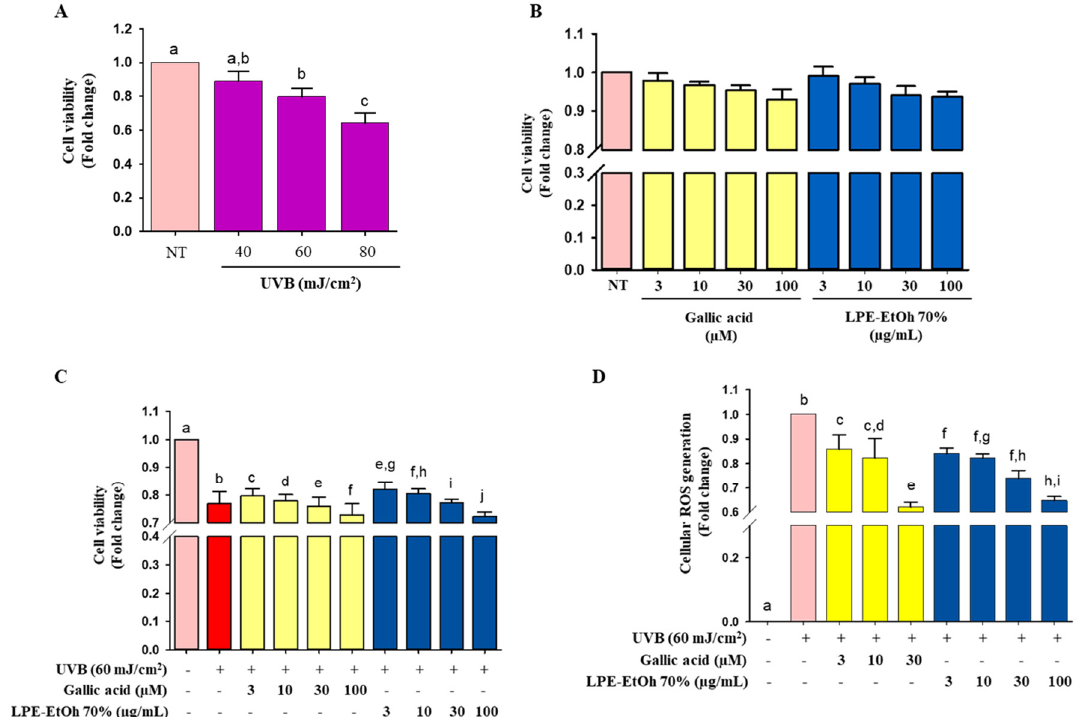
Figure 3. Cell viability activity of ethanolic 70% extract of Lablab purpureus L. (LPE) was evaluated by 3-(4,5-dimethylthiazol-2-yl)-2,5-diphenyltetrazolium bromide (MTT) assay. ( A ) HaCaT cells were seeded (1 × 10 5 cells / mL) in 96-well plates for 24 h and then irradiated with UVB (40, 60, and 80 mJ / cm 2 ) followed by incubation for 24 h; ( B ) HaCaT cells (1 × 10 5 cells / mL) were treated with 2 µ L of LPE ethanolic 70% extract (3–100 µ g / mL) and gallic acid (3–100 µ M) as a standard for 24 h. ( C ) HaCaT cells (1 × 10 5 cells / mL) were treated with LPE (3–100 µ g / mL) and GA: gallic acid (10 µ M) for 24 h and then irradiated with UVB (60 mJ / cm 2 ). ( D ) Pretreated HaCaT cells by LPE ethanolic 70% extract (3–100 µ g / mL) and gallic acid (3–30 µ M) were exposed by UVB irradiation (60 mJ / cm 2 ), reactive oxygen species (ROS) levels were determined according to the Section 4. Statistical values are expressed as the mean ± SD ( n = 3). All the tests were performed in triplicate. Di ff erent letters stand for statistically significant each other ( p < 0.05) performed by one-way ANOVA followed by Tukey’s test. Orange color means non UV-B treated, red color means UV-B treated; yellow color means gallic acid treated; blue color meant sample (LPE) treated groups, respectively.